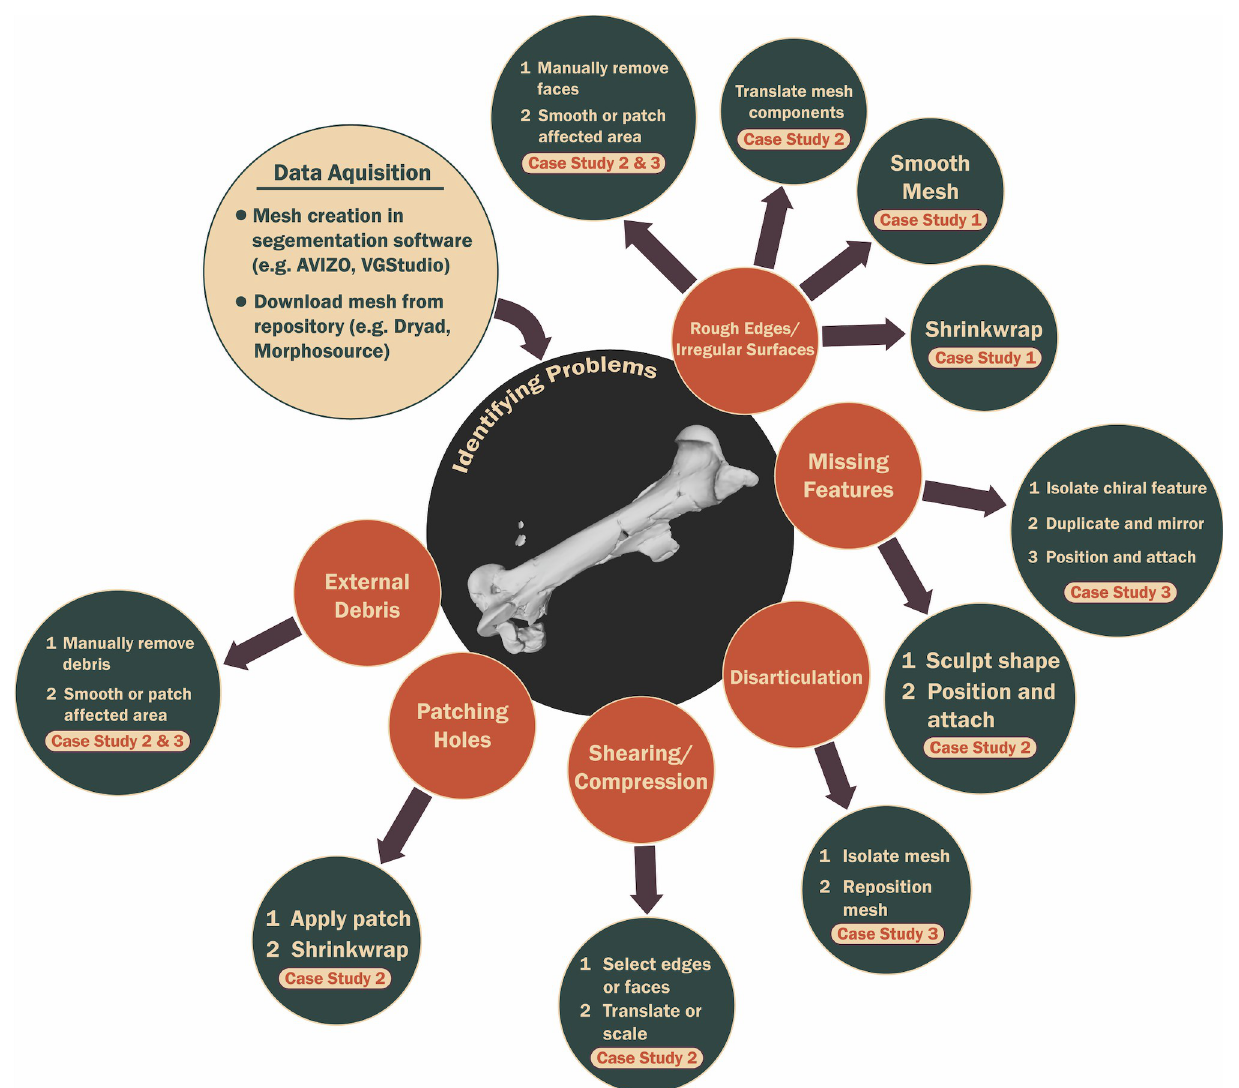
Fig 5. Summary workflow to address common issues with 3D imaging data. Step-by-step guidelines with examples and associated 3D object files can be found in the supplementary information (S1 File).